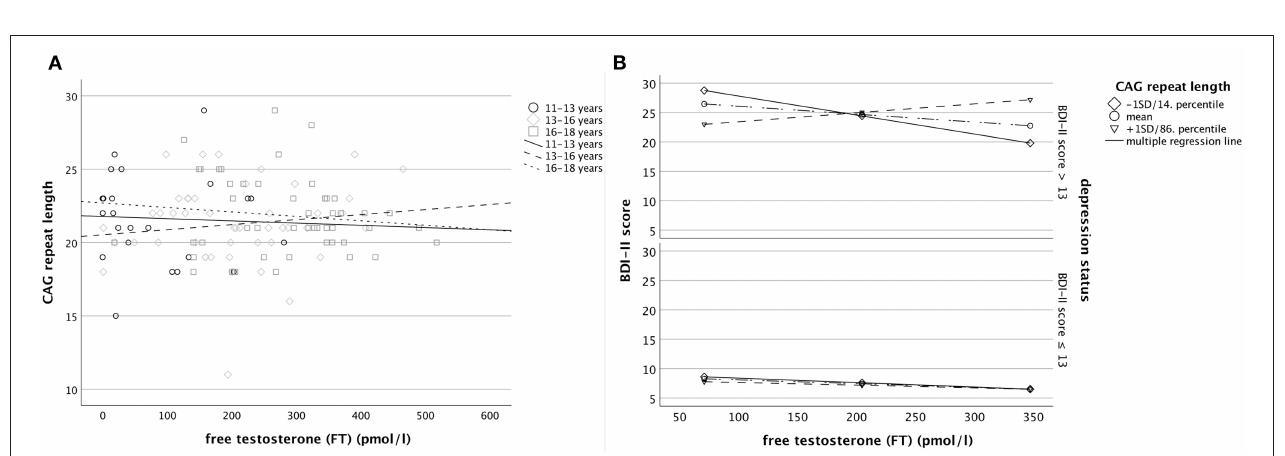
FIGURE 1 | Percentage of patients with regard to the respective sample with a BDI-II score > 13 (black bars), a diagnosis of MDD confirmed by clinical assessment (white bars), or a BDI-II score ≤ 13 (gray bars) considering (A) testosterone and (B) free testosterone levels as well as (C) BDI-II score and (D) the CAG repeat length (from left to right and upper to lower panel).